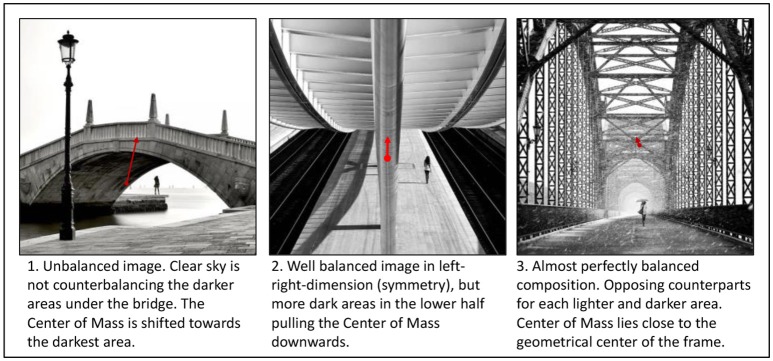
The red dot indicates the objective luminance Center of Mass, according to the DCM measure. The arrow is pointing towards the geometric center of the composition. The shorter the arrow, the better balanced the composition. DCM scores are as follows: Photo 1. BALDCM = 27.4; Photo 2. BALDCM = 5.27; Photo 3. BALDCM = 1.54.